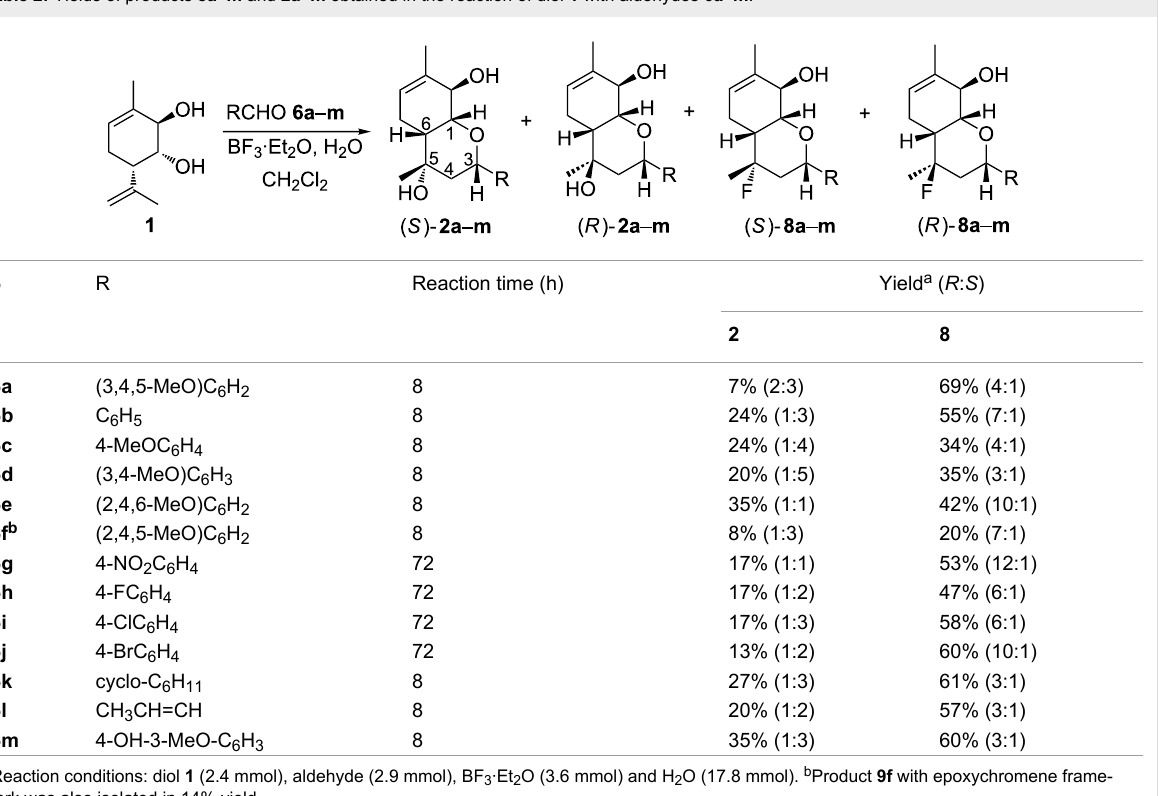
Table 2: Yields of products 8a–m and 2a–m obtained in the reaction of diol 1 with aldehydes 6a–m .